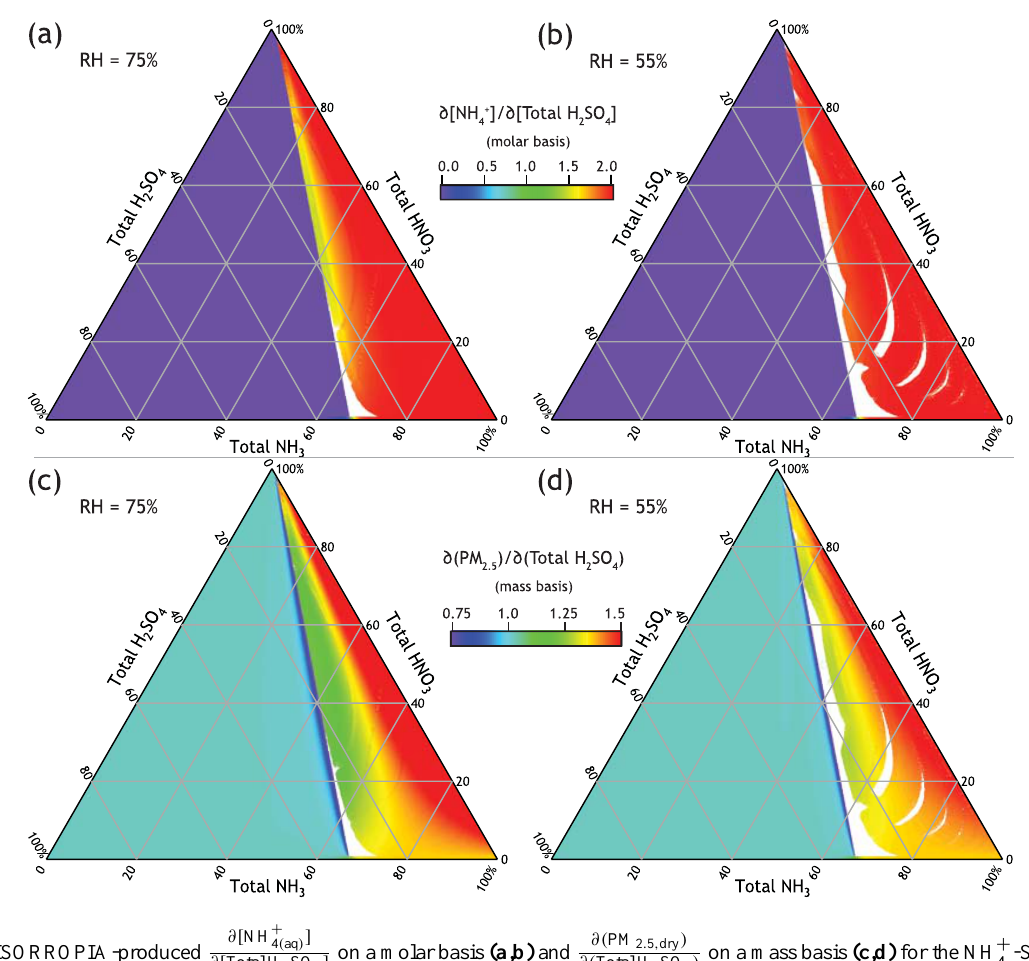
Fig. 6. ANISORROPIA-produced NO − -H 2 O aerosol system at RH of 75% (a,c) and 55% (b,d) and a temperature of 300K. The axes convey the percent a total species 3 (adjacent label) contributes to the molar composition of the system. White space denotes error occurrence.